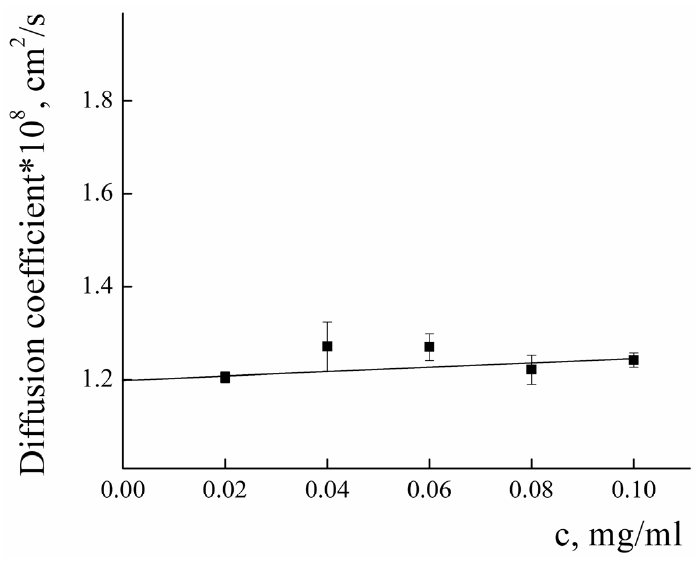
Figure 11. Concentration dependence of the diffusion coefficient of PLAMs–PTX in Tris buffer with pH 7, c = 0.01 M, 25 °C.